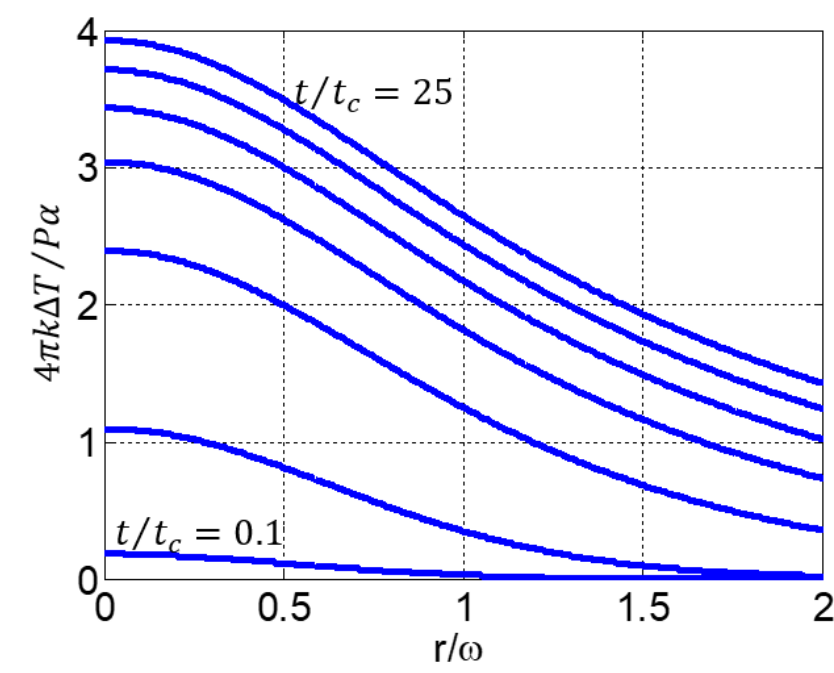
Figure 1. Temperature evolution in the thermal lens at various times (from lowest to highest: t / t c = 0.1, 1, 5, 10, 15, 20 and 25).